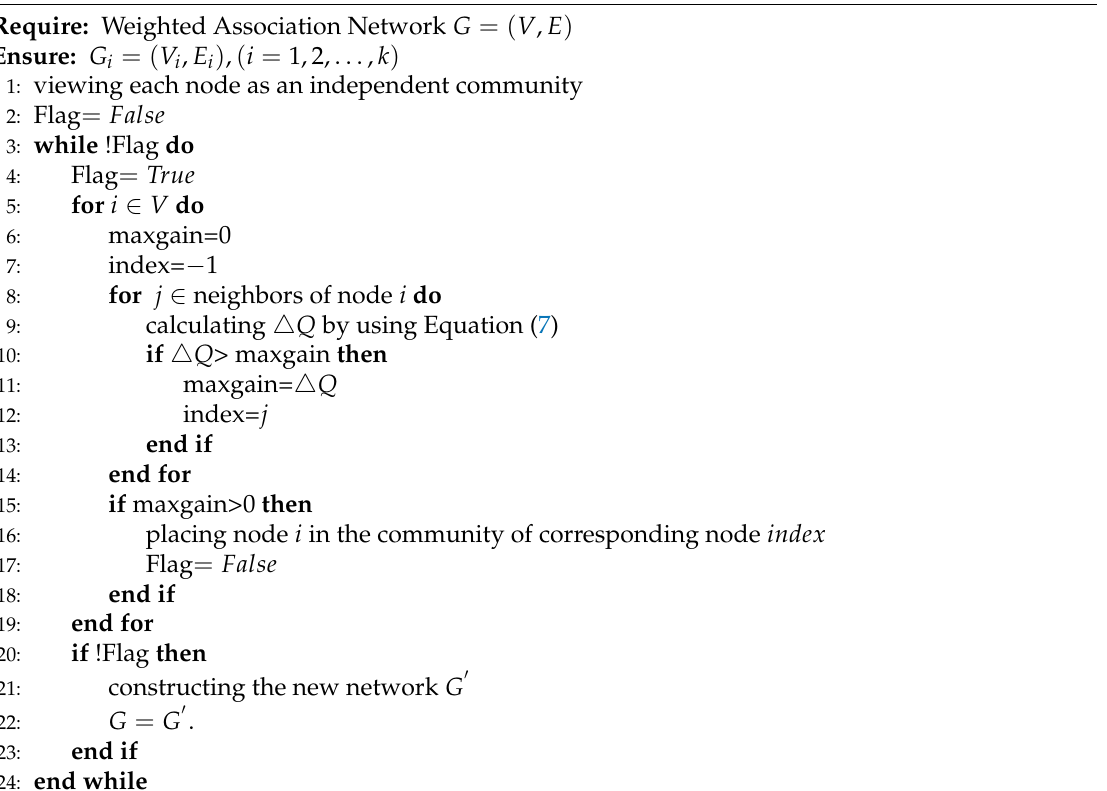
Algorithm 1 Algorithm to discover student